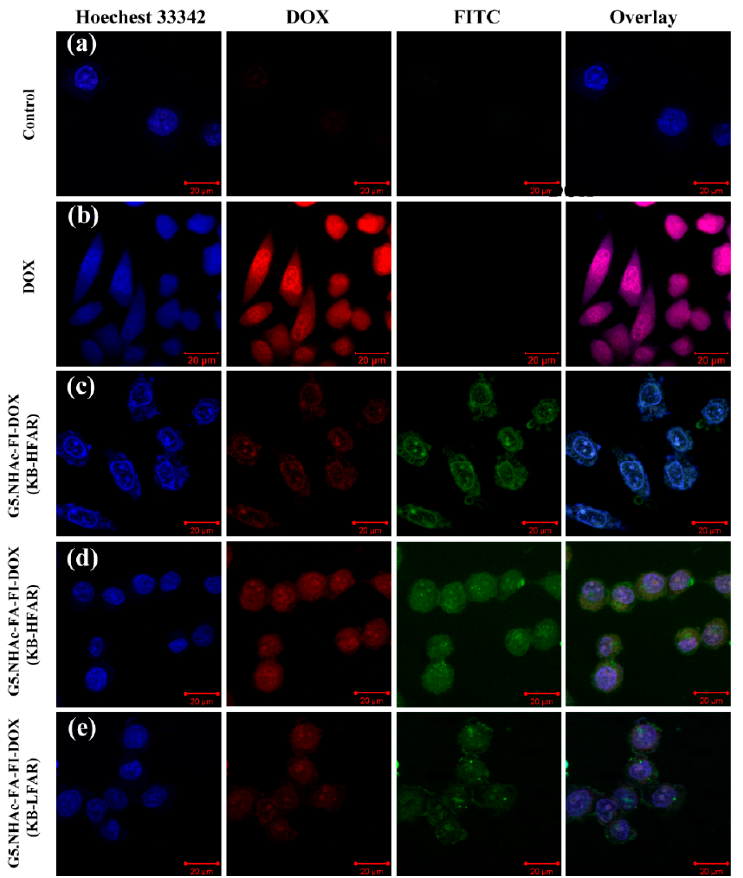
Figure 7. Confocal laser scanning microscopic images of KB cells having high-level of FAR expression (KB-HFAR) cells treated with ( a ) PBS, ( b ) free DOX (10 μ M), ( c ) G5.NHAc-FI-DOX (40 μ M DOX-equiv.), ( d ) G5.NHAc-FA-FI-DOX (40 μ M DOX-equiv.), and ( e ) KB cells having low-level of FAR expression (KB-LFAR) cells treated with G5.NHAc-FA-FI-DOX (40 μ M DOX-equiv.).